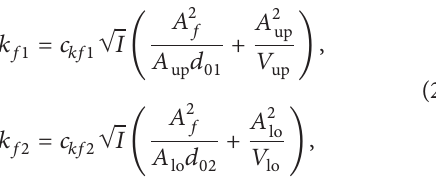
Figure 28: Flexible-valve